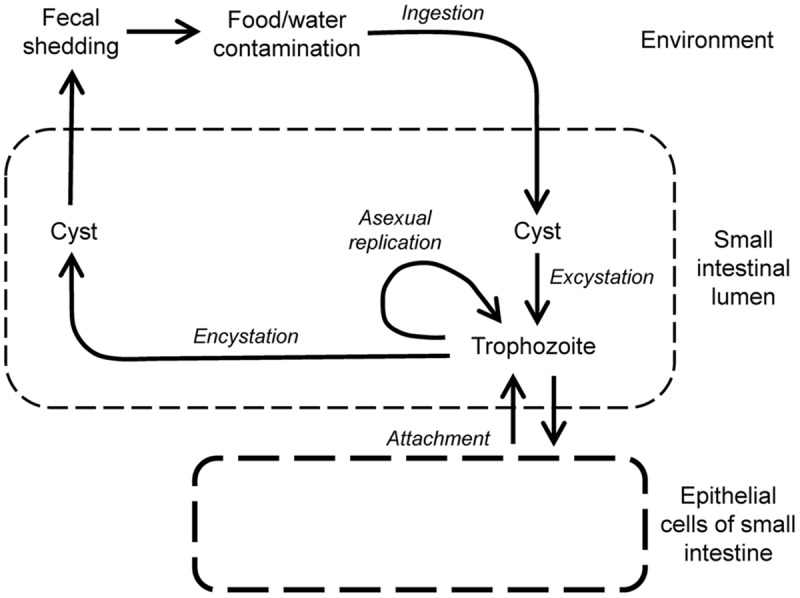
Life cycle of Giardia lamblia. Infection begins by oral uptake of cysts, which excyst in stomach and small intestine to form trophozoites, the replicating, disease-causing form of the parasite. Trophozoites are motile, and maintain their presence in the small intestine by regulated attachment to and detachment from the small intestinal epithelium, but they do not invade epithelial cells. Trophozoites can also differentiate by encystation in the small intestine into cysts, which are shed in the feces and are infectious for new hosts.